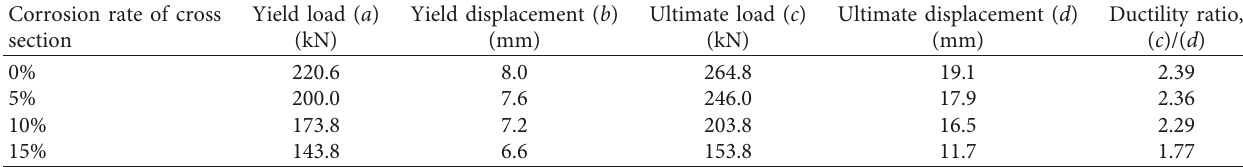
Table 8: The key point value of the load-displacement curve under coupling factors.